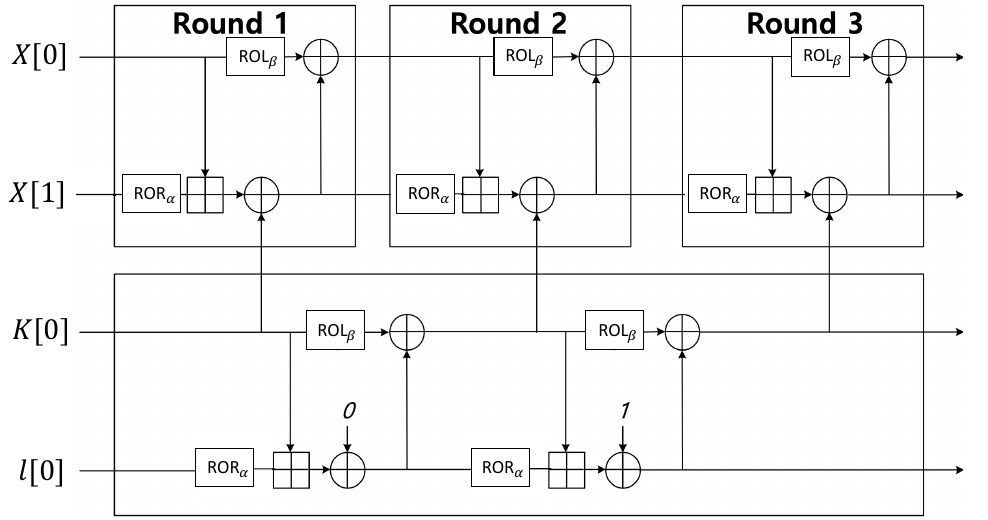
Figure 6. Overview of SPECK( m = 2) block cipher: key schedule and